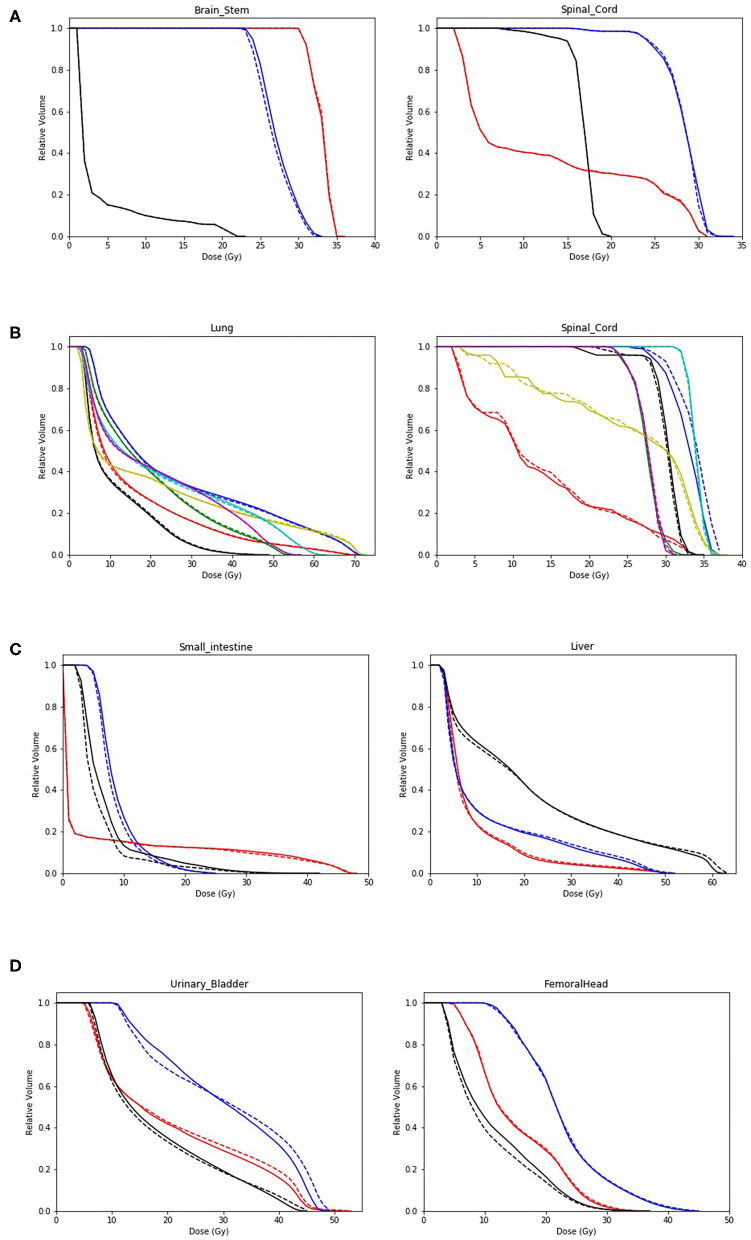
Dose volume histogram (DVH) comparison between the planned and reconstructed doses of two organs at risk (OARs) per anatomic site. Head and neck: brain stem and spinal cord (A); Thorax: lung and spinal cord (B); Abdomen: small intestine and liver (C); and Pelvis: urinary bladder and femoral head (D). Solid and dotted lines of the same color indicate the cumulated and planned dose, respectively, for a specific patient.